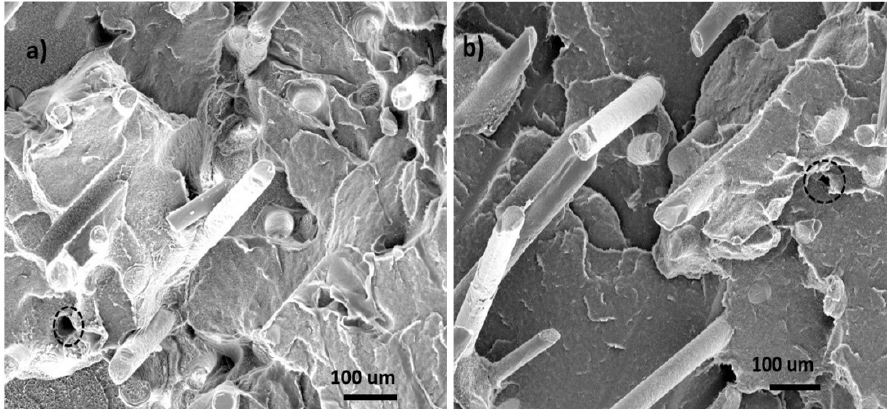
Figure 1. Scanning electron microscopy (SEM) micrographs of fractured surfaces of glass fiber (GF) filled high density polyethylene (HDPE) AD60 composites. ( a ) 10 wt % GF; ( b ) 30 wt %